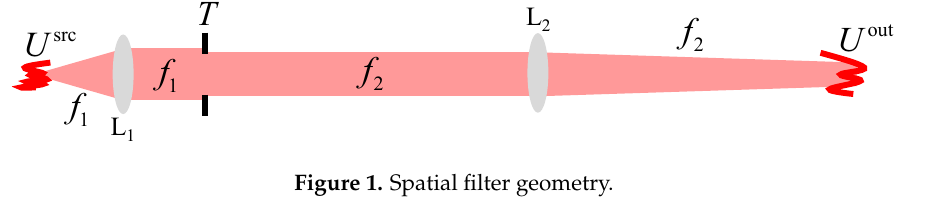
Figure 1. Spatial filter